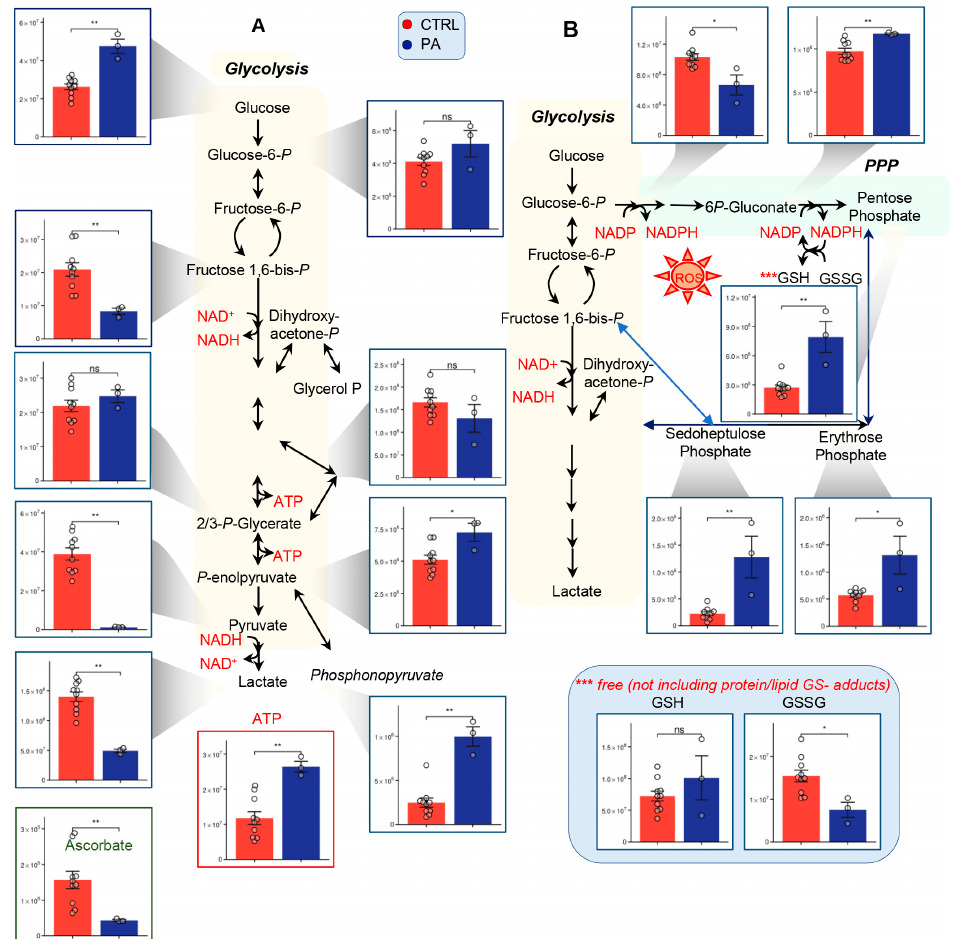
Figure 2. PA remodels (A) glycolysis and the (B) pentose phosphate pathway in RBCs. Y-axes represent peak area (arbitrary units). Asterisks indicate significant results, error bars represent ± standard error of the mean (unpaired t -test, 2-tailed distribution, * p < 0.05, ** p < 0.01). With the exception of 6-phosphogluconolactone, the metabolomic analyses of the PA samples revealed higher levels of most PPP metabolites, when compared to the controls (e.g., 6-phosphogluconate and ribose phosphate/pentose phosphate isobars and non- oxidative phase erythrose phosphate and sedoheptulose phosphate—Figure 2B).